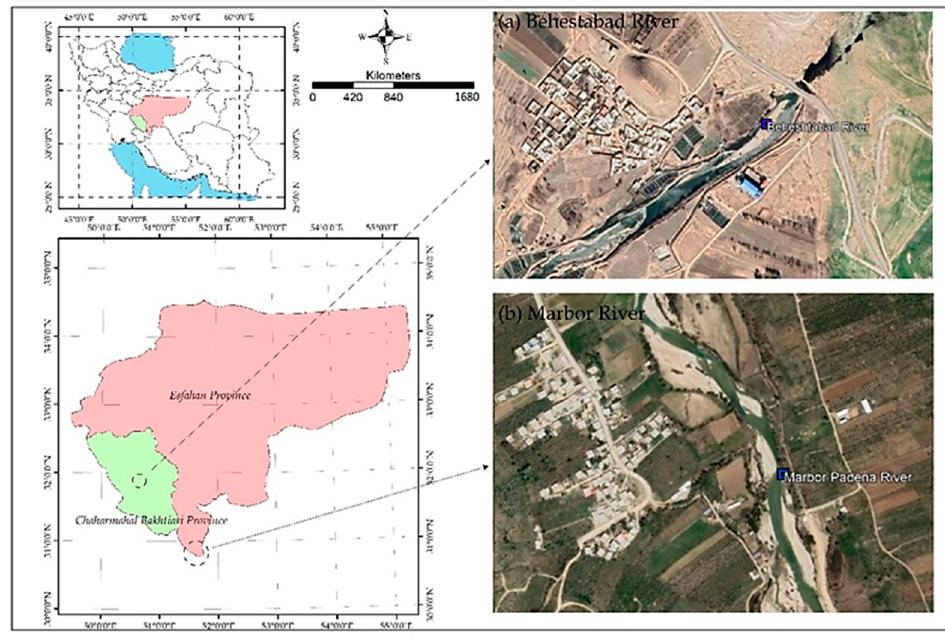
Figure 1. Location of study sites ( a ) Beheshtabad River and ( b ) Marbor River.